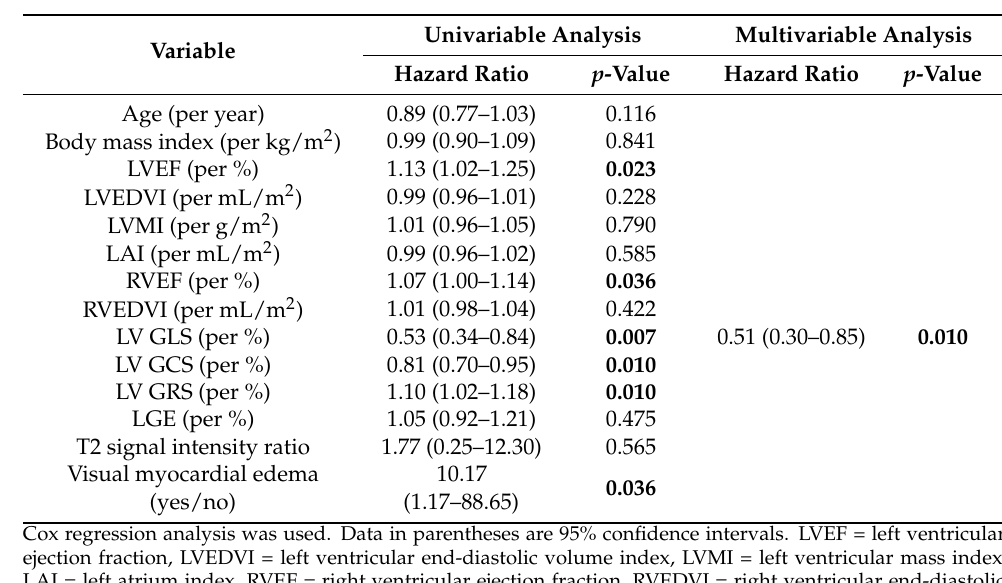
Table 3. Influence of cardiac magnetic resonance imaging data for the prediction of left ventricular ejection fraction recovery in patients with acute peripartum cardiomyopathy.